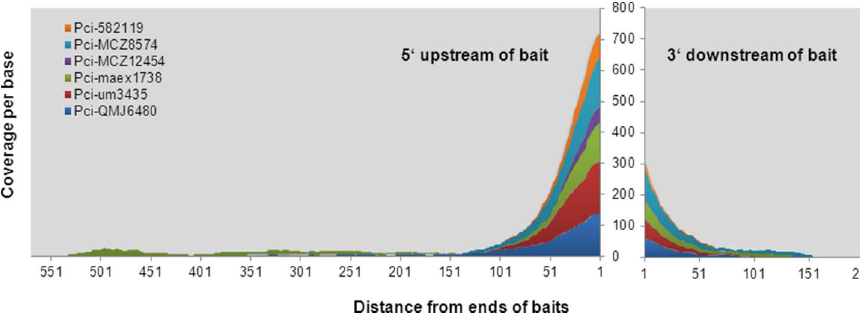
Figure 2. Mitochondrial DNA coverage per base beyond bait sequences for six historical koala samples. Reads mapping to the koala mitochondrial DNA genome (AB241053) are presented as per base coverage starting from the first base beyond the bait. The 5 9 end of the bait is shown to the left of the X axis 3 9 to the right. The six historical koala age and sample information are shown in Table S1. The average library insert size for all six libraries was 93 bp. No correlation between year of sample collection and extension beyond the bait end was observed. The results demonstrate that only limited flanking sequence was captured for the six historic samples tested.